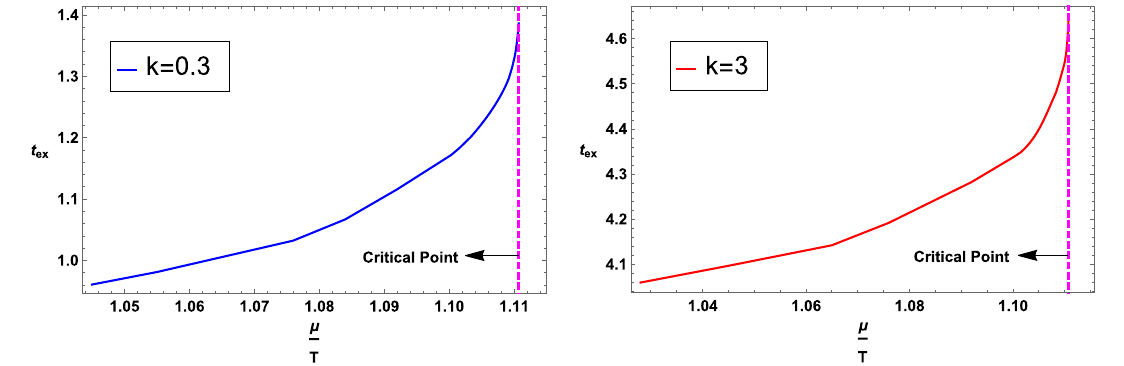
Fig. 5 Excitation time t ex as a function of μ ues of interquark distance l = 0 . 27, the transition time k = 0 . 3 and the temperature T = 0 . 37 ( lT = 0 . 10). Right: We fixed the values of